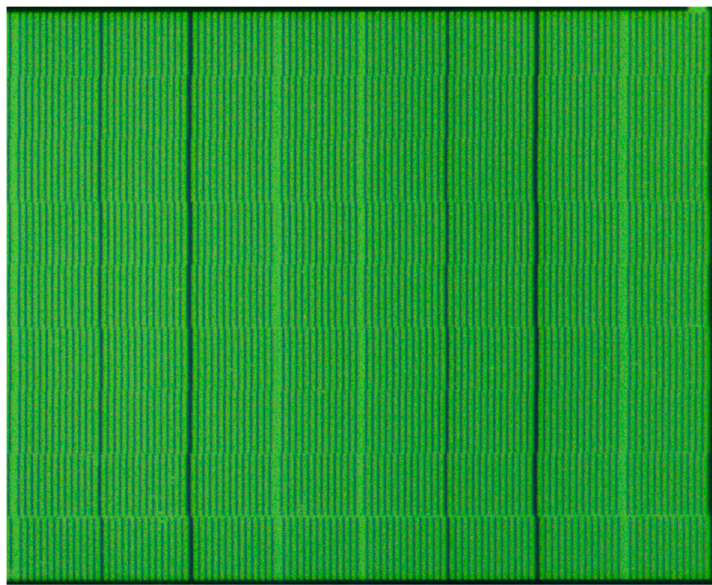
Figure 9. Part of incremental windows of fabricated index grating.